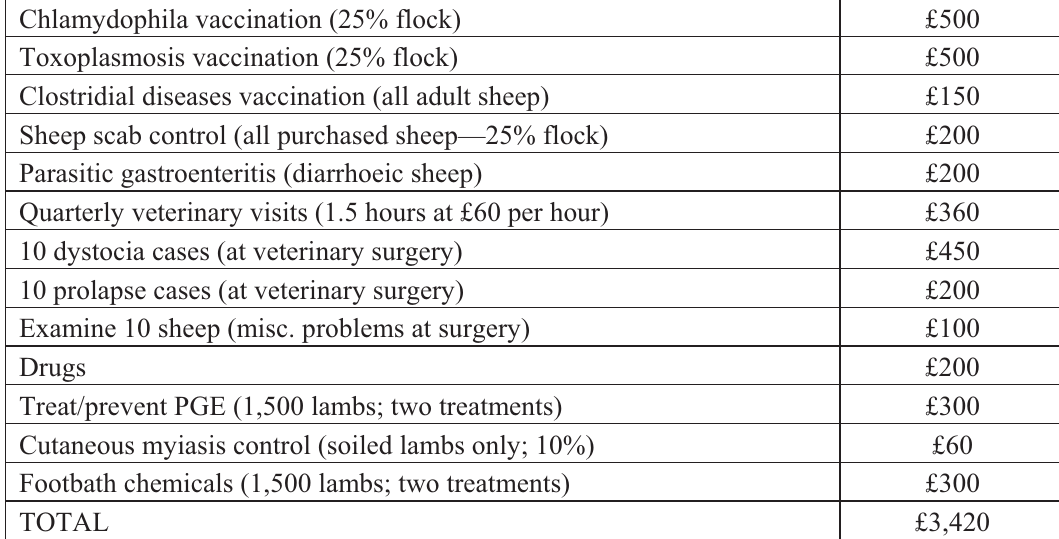
Table 5. Annual cost of operating a flock health plan for a 1,000 ewe lowland flock in the UK producing 1,500 lambs sold for slaughter by 5 month-old (adapted from [67]). Chlamydophila vaccination (25% flock) £500 Toxoplasmosis vaccination (25% flock) £500 Clostridial diseases vaccination (all adult sheep) £150 Sheep scab control (all purchased sheep—25% flock) £200 Parasitic gastroenteritis (diarrhoeic sheep) £200 Quarterly veterinary visits (1.5 hours at £60 per hour) £360 10 dystocia cases (at veterinary surgery) £450 10 prolapse cases (at veterinary surgery) £200 Examine 10 sheep (misc. problems at surgery) £100 Drugs £200 Treat/prevent PGE (1,500 lambs; two treatments) £300 Cutaneous myiasis control (soiled lambs only; 10%) £60 Footbath chemicals (1,500 lambs; two treatments) £300 TOTAL